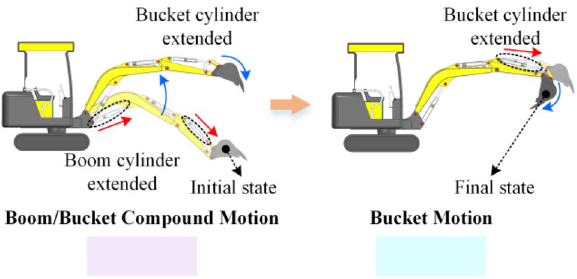
Figure 13 Schematic diagram of the boom/bucket compound